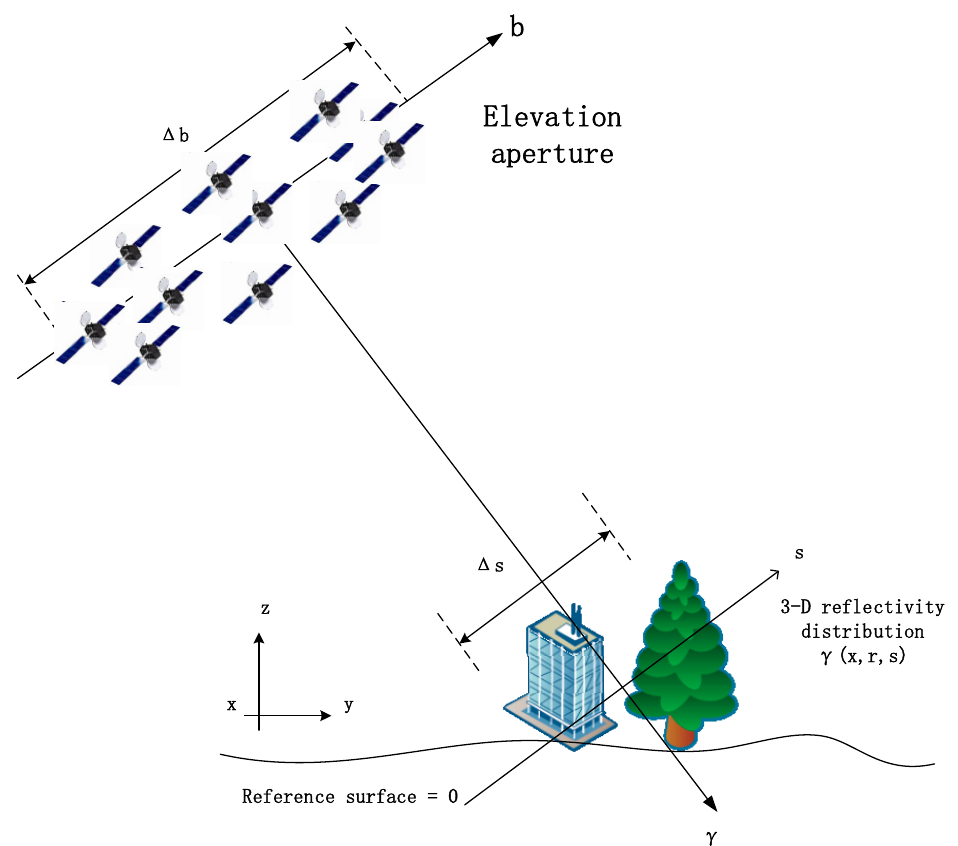
Figure 1. A schematic of the TomoSAR imaging geometry. The elevation synthetic aperture was built up by multi-pass SAR data from slightly different view angles. The flight direction was orthogonal out of the plane. Δ b is the elevation synthetic aperture length, x is the azimuth direction, r is the range direction, and s is the elevation direction.